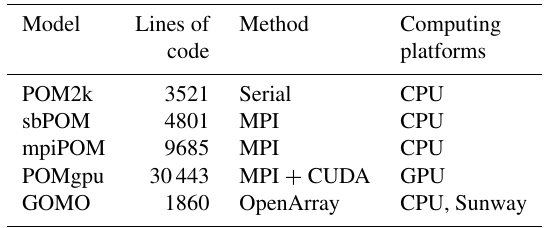
Table 3. Comparing GOMO with several variations in the